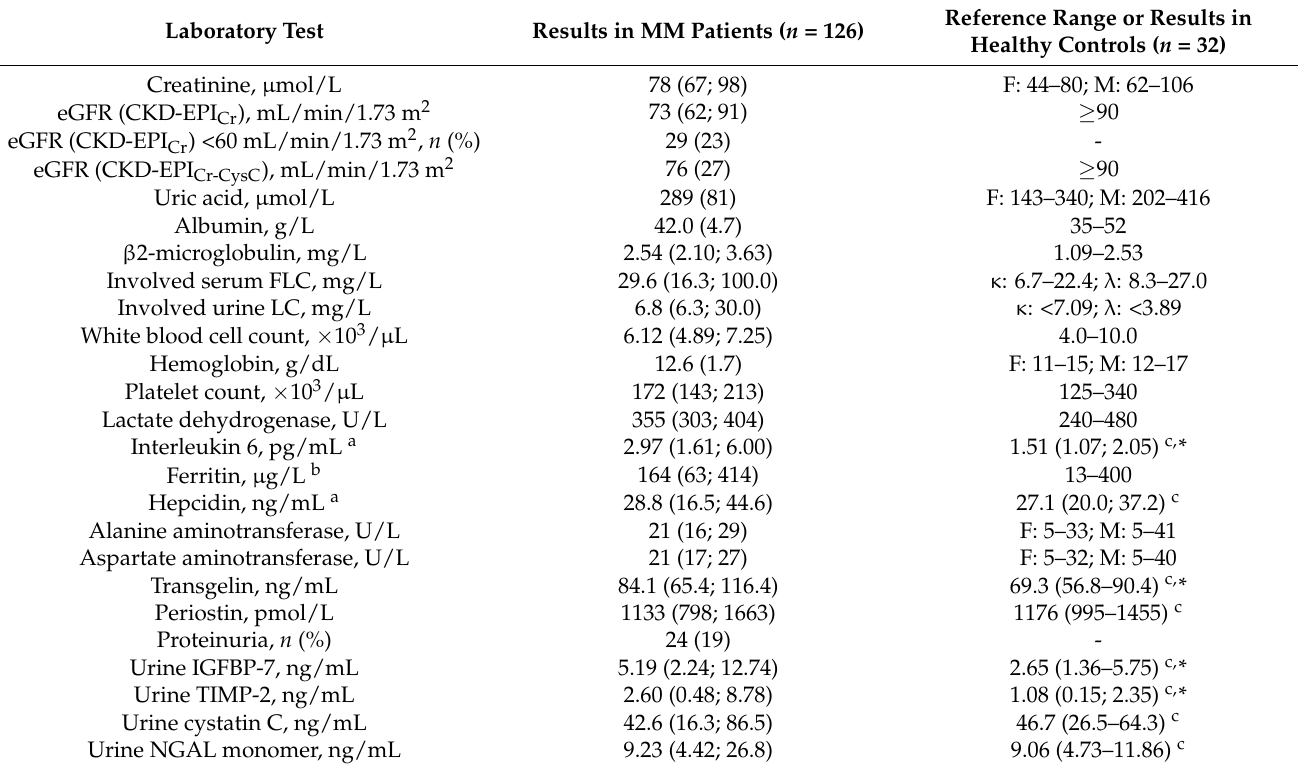
Table 2. Baseline results of laboratory tests in the studied group in comparison to reference ranges used in the study center for routine laboratory tests or values observed in 32 healthy controls for non-standard laboratory tests ( c ). Data are shown as mean (standard deviation) or median (lower; upper quartile) unless otherwise